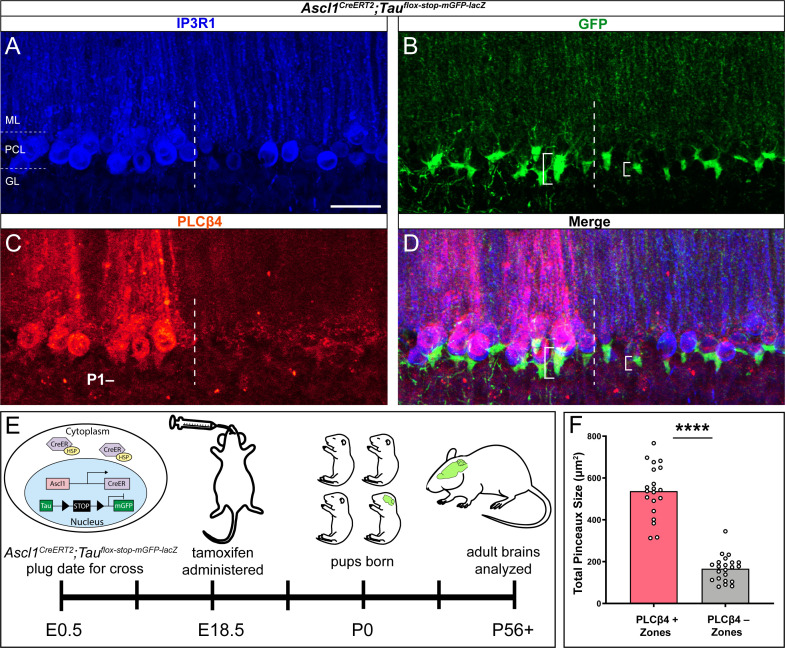
Genetically marked basket cell pinceaux are distinguished by size according to Purkinje cell zones.(A, B, C) Coronal sections cut through the cerebellar cortex showing IP3R1 (blue, PC), GFP (green, pinceau), and PLCβ4 (red, PC) expression in Ascl1CreERT2;Tauflox-stop-mGFP-lacZ tissue. Dotted line indicates the Purkinje cell boundary between a PLCβ4-positive (left) and PLCβ4-negative (right) zone. Scale bar in A is 50 μm. (D) Merged IP3R1, GFP, and PLCβ4 expression. Brackets highlight genetically labeled-pinceaux of different sizes between PLCβ4-positive and -negative zones, which is consistent with the results from the HCN1-labeled pinceaux. (E) Schematic of experimental timeline and procedure to generate genetically labeled basket cells and pinceaux. Upon tamoxifen administration, the CreER protein that was sequestered in the cytoplasm by HSP is now able to enter the nucleus and induce recombination at loxP sites. Neurons are marked with GFP after recombination. (F) Quantification of pinceau area across PLCβ4 zones reveals significantly higher total pinceau size in PLCβ4-positive zones (mean = 537.7 µm², SD = 125.2 µm²) compared to PLCβ4-negative zones (mean = 166.5 µm², SD = 62.17 µm²). Each data point indicates the total area of multiple HCN1-labeled pinceaux within a 100 μm-wide region of a PLCβ4-positive or -negative Purkinje cell zone, in µm² (N = 4, n = 8 sections, 20 PLCβ4-positive zones and 22 PLCβ4-negative zones; ****p<0.0001).Figure 6—source data 1.Source data for representative graphs in Figure 6.